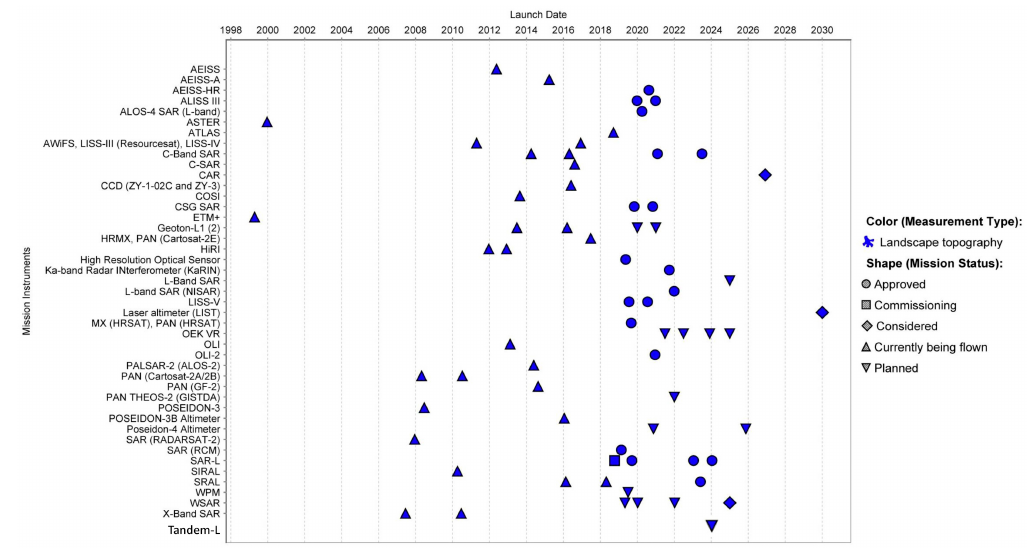
Figure 12. Current and future spaceborne RS mission instruments for monitoring landscape topography with information about the mission status, according to the CEOS database [260].